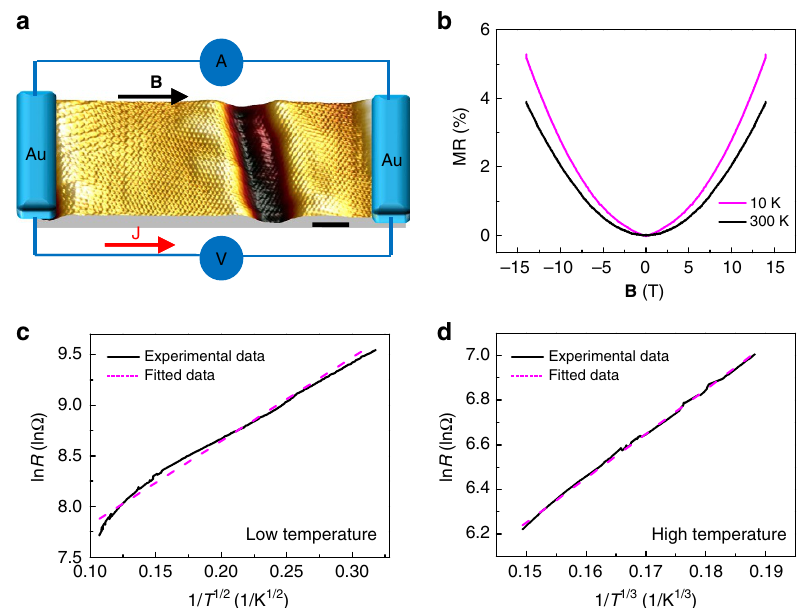
Figure 4 | MR and transport properties probing one to two NBs. ( a ) Schematic drawing of the graphene devices with nano-gap contacts. The spacing of the nano-gap was B 28nm. Scale bar, 3nm. ( b ) MR curves of the nanocontact device measured at 10 and 300K, with the magnetic field in the graphene plane aligned along the direction of current flow ( y ¼ 90 (cid:2) ). ( c ) The log resistance ln( R ) can be fitted as a straight line with respect to 1/ T 1/2 in the low temperature range 10–80K, indicating 1D transport from the VRH model. ( d ) At higher temperatures up to 300K, the ln( R ) behaviour is different and is best fitted as a function of 1/ T 1/3 , suggesting 2D VRH